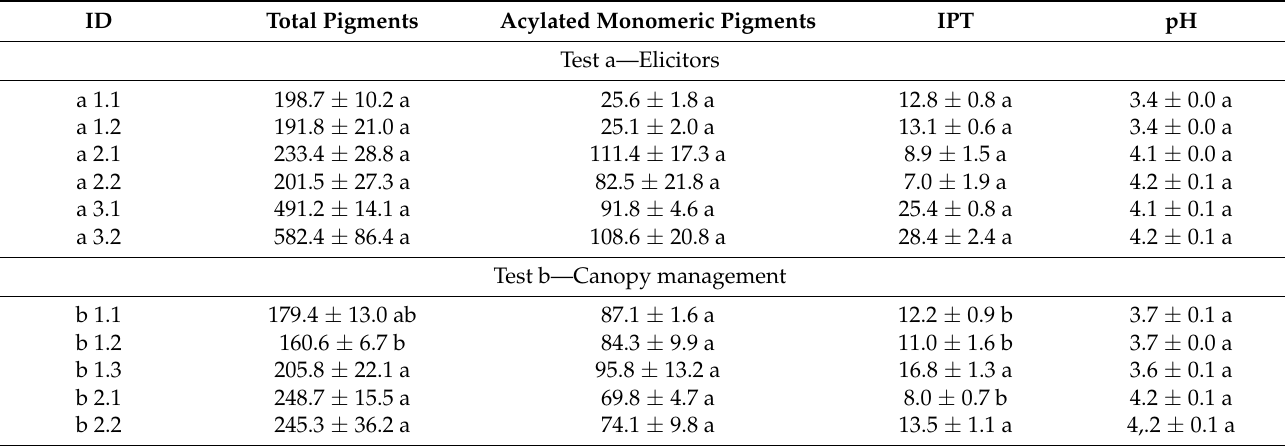
Table 3. Total phenolic compounds and colour parameters (UV-Vis) and main anthocyanins (HPLC-DAD). Comparison of blocks with elicitors and canopy management systems against controls. Average and standard deviation. Different letters indicate statistical differences ( p < 0.05) for each treatment (e.g., between a1.1 and a1.2). ID Total Pigments Acylated Monomeric